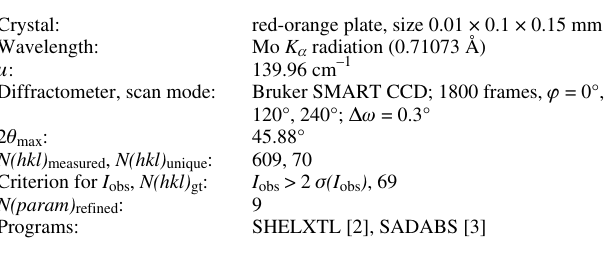
Table 1. Data collection and